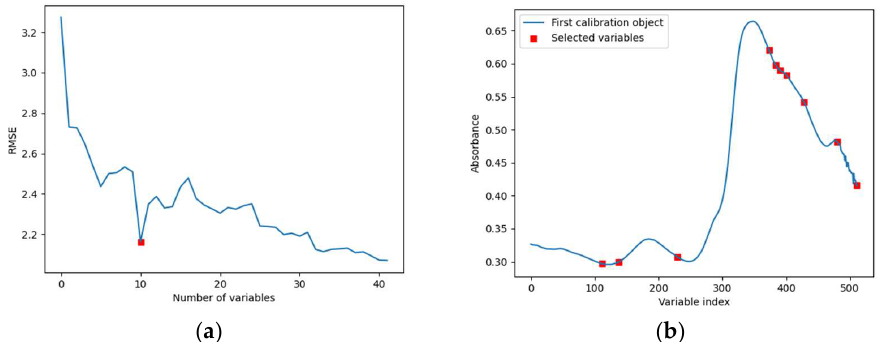
Figure 10. SPA feature selection results: ( a ) Optimal number of variables; ( b ) Location of feature.